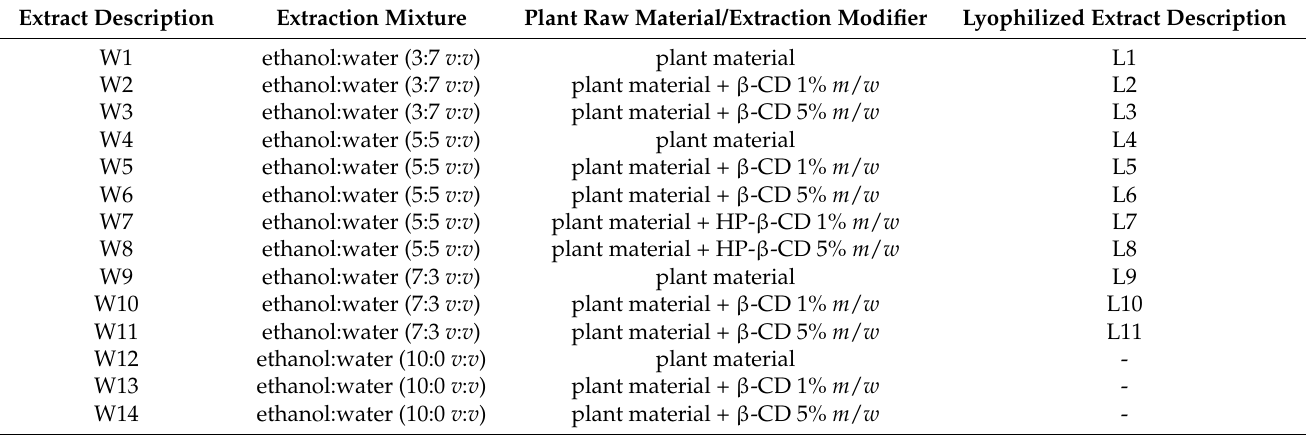
Table 1. Chemical composition of extracts and lyophilized